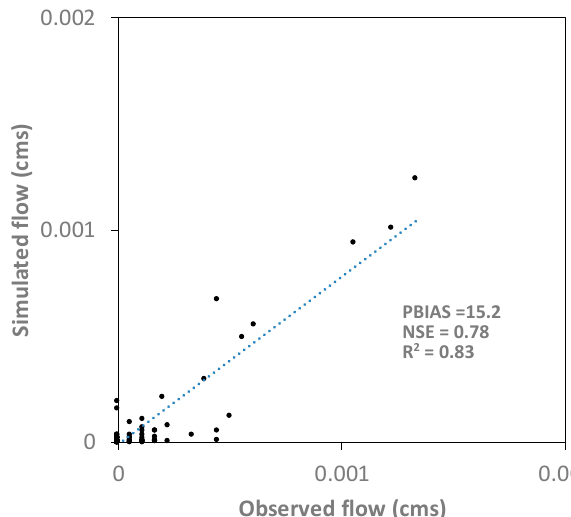
Water 2019 , 11 , x FOR PEER REVIEW Figure 13. Observed versus modeled outflow hydrograph. Figure 13. Observed versus modeled outflow hydrograph.